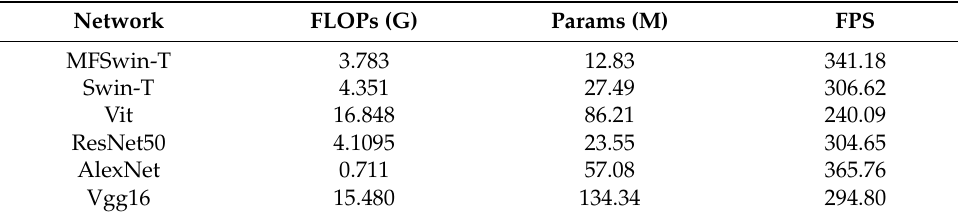
Table 9. Performance comparison results of different